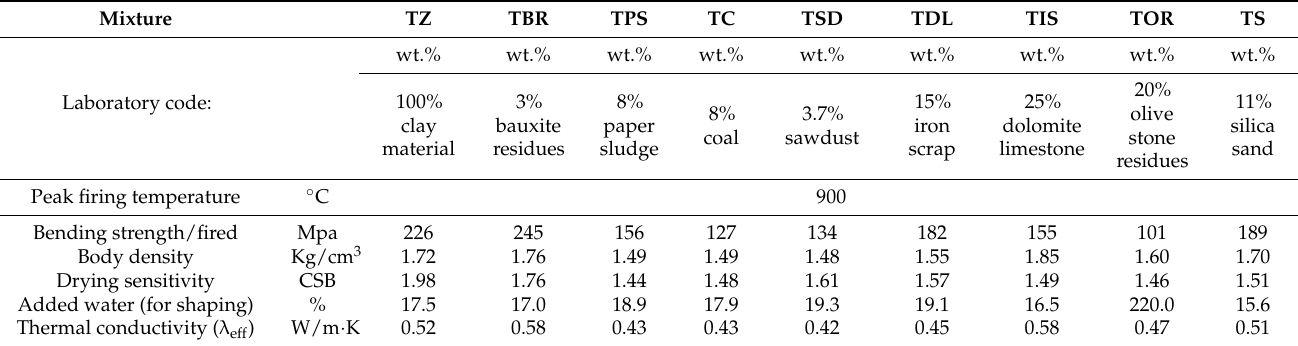
Table 20. Summary of results from the constructed